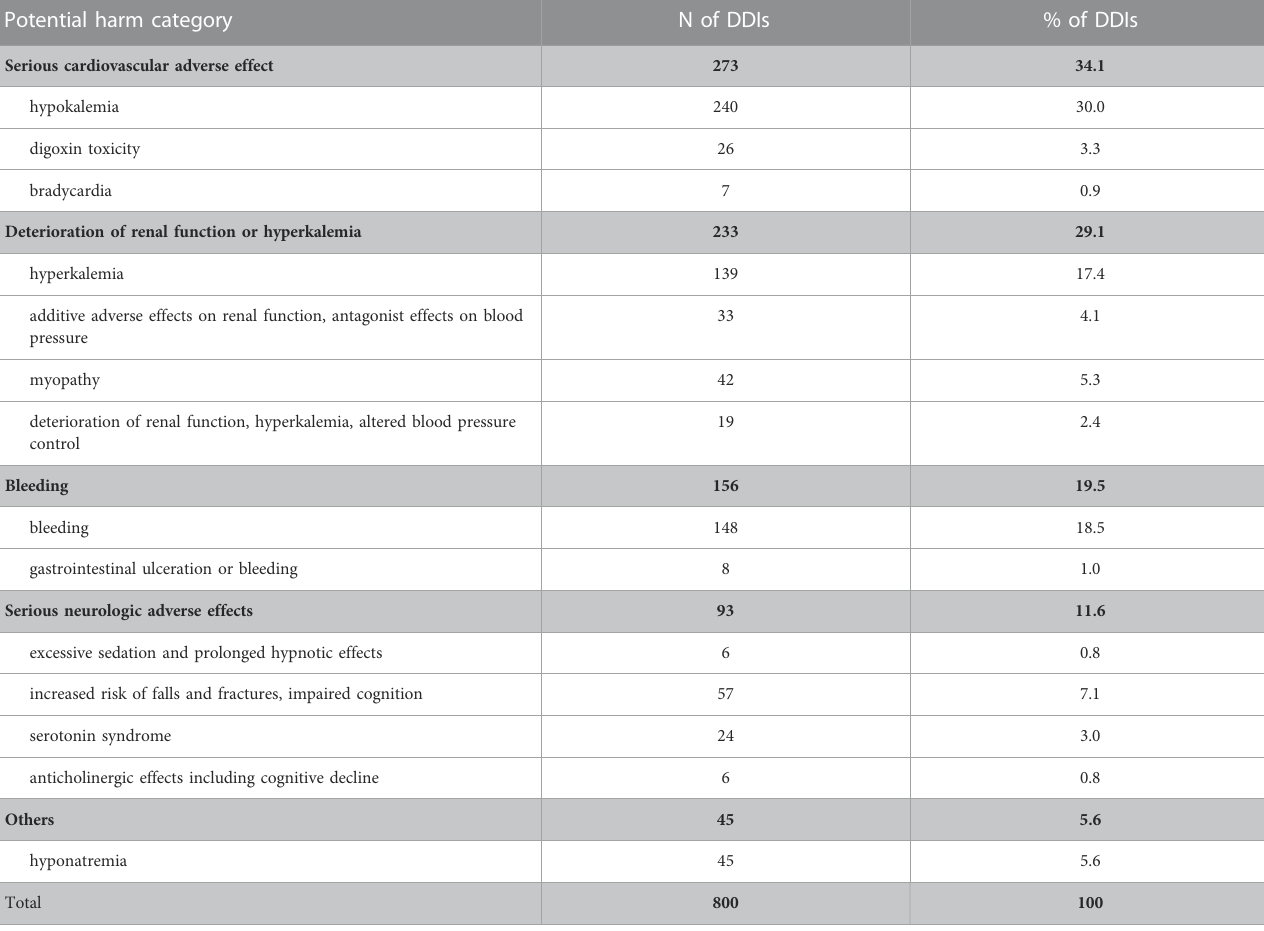
TABLE 1 The number of drug combinations potentially causing clinically signi fi cant DDIs with corresponding potential harm category according to Zerah et al., 2021. Potential harm category N of